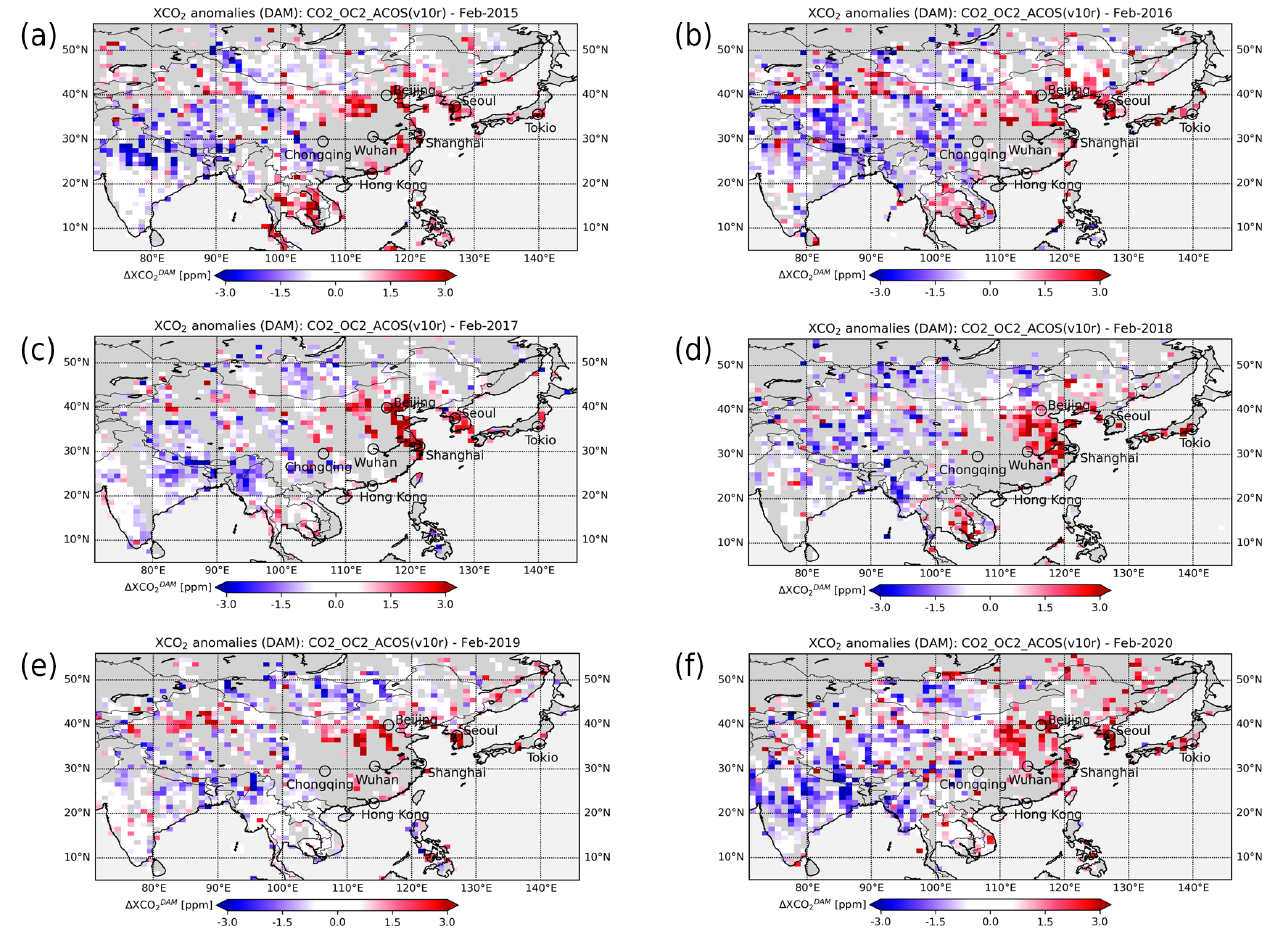
Figure 5. As Fig. 4 but for (a) February 2015 to (f) February